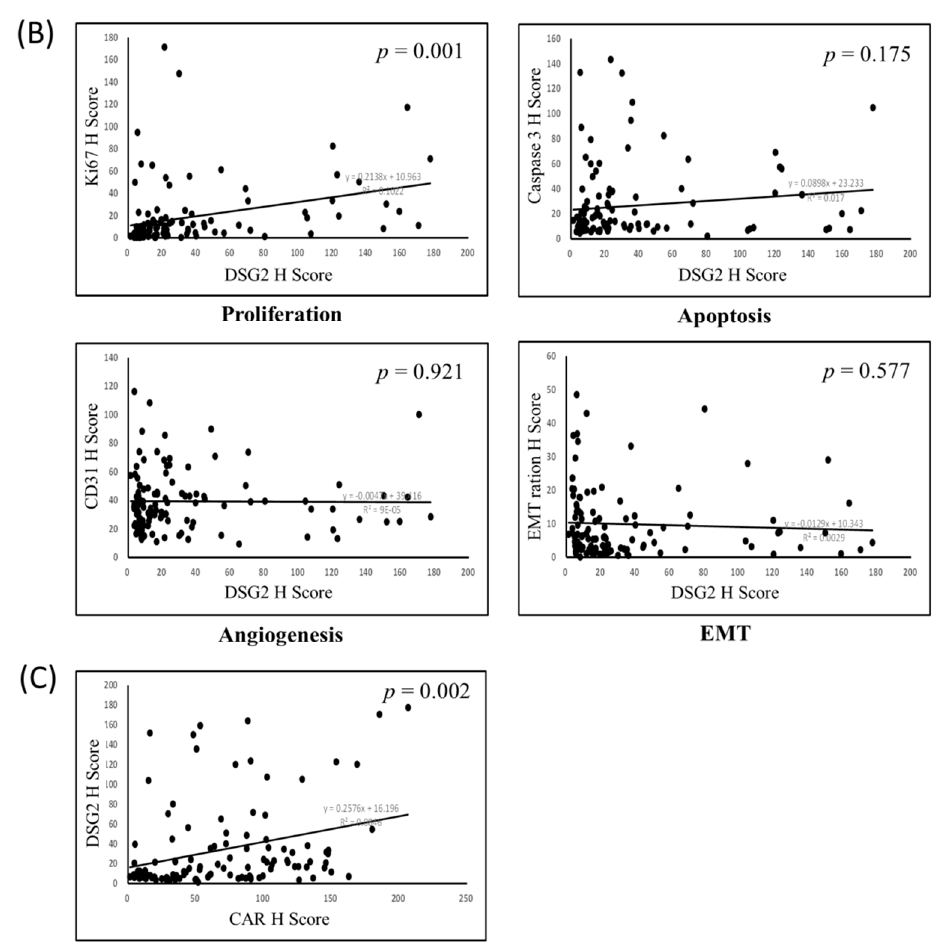
Figure 6. Bi-variant correlation for ( A ) proliferation, apoptosis, angiogenesis, and epithelial–mesenchymal transition (EMT) with CAR; ( B ) proliferation, apoptosis, angiogenesis, and EMT with DSG2; and ( C ) the correlation of CAR with DSG2.